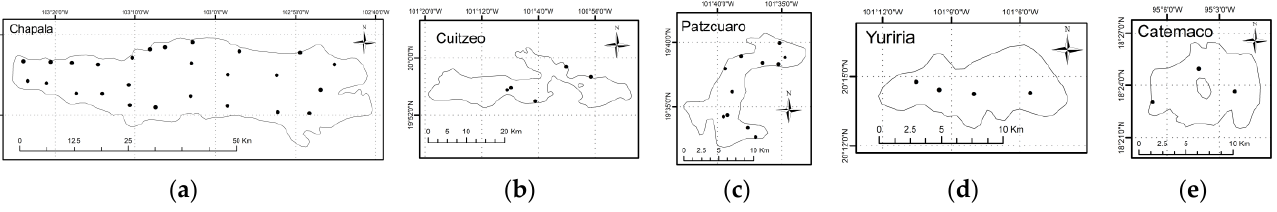
Figure 2. Location of the RNMCA sampling stations (black dots) in the lakes: ( a ) Lake Chapala, ( b ) Lake Cuitzeo, ( c ) Lake Pátzcuaro, ( d ) Lake Yuriria, and ( e ) Lake Catemaco. The scale is different for each lake.